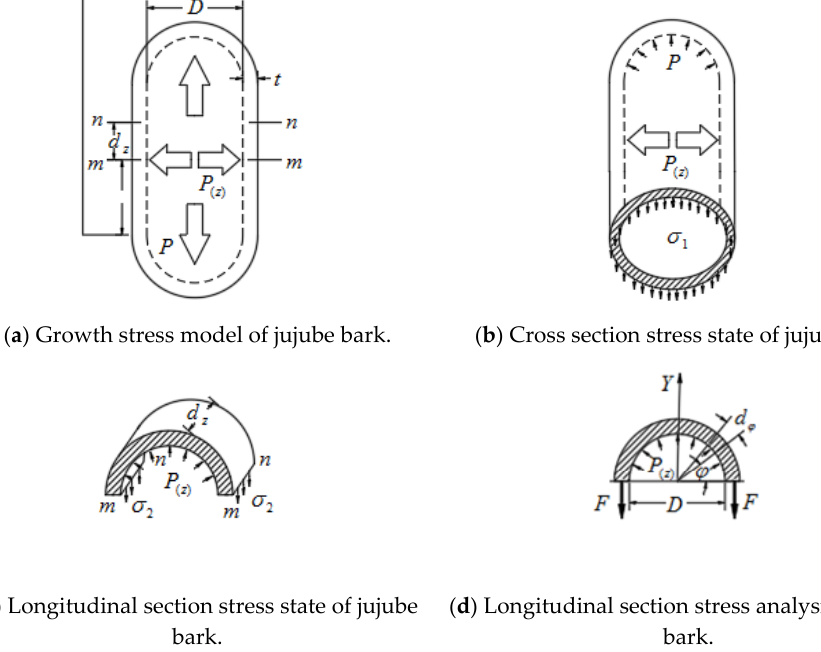
( c ) Longitudinal section stress state of jujube ( d ) Longitudinal section stress analysis of jujube bark. bark. Figure 3. Simplified growth stress model of jujube bark. Note: In Figure ( a ), Z is the axial ordinate of jujube, mm; P is the axial growth pressure of jujube bark, MPa; P ( z ) is the pressure caused by the circumferential growth stress of jujube bark, MPa; D is the xylem diameter of jujube, mm; t is the thickness of jujube bark, mm; m - m and n - n are cross sections, and d z is the distance between the two cross sections, mm. In Figure ( b ), σ 1 is the axial growth stress of jujube bark, MPa. In Figure ( c ), σ 2 is the growth stress of the longitudinal section of jujube bark, MPa. In Figure ( d ), F is the resultant force of the longitudinal section stress, N; ϕ is the arc angle of the cross section, rad; d ϕ is the arc’s differential